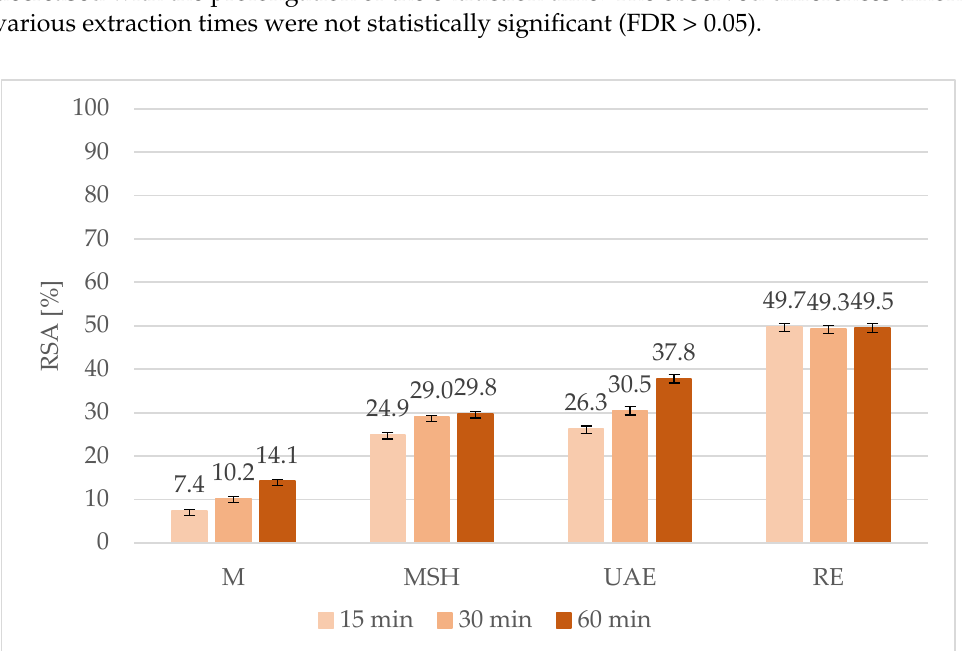
Figure 1. In fl uence of extraction technique and conditions on DPPH radical scavenging activity of maca extracts obtained using 96% ethanol as the solvent (M—maceration; MSH—maceration with shaking; UAE—ultrasound-assisted extraction; RE—re fl ux extraction).